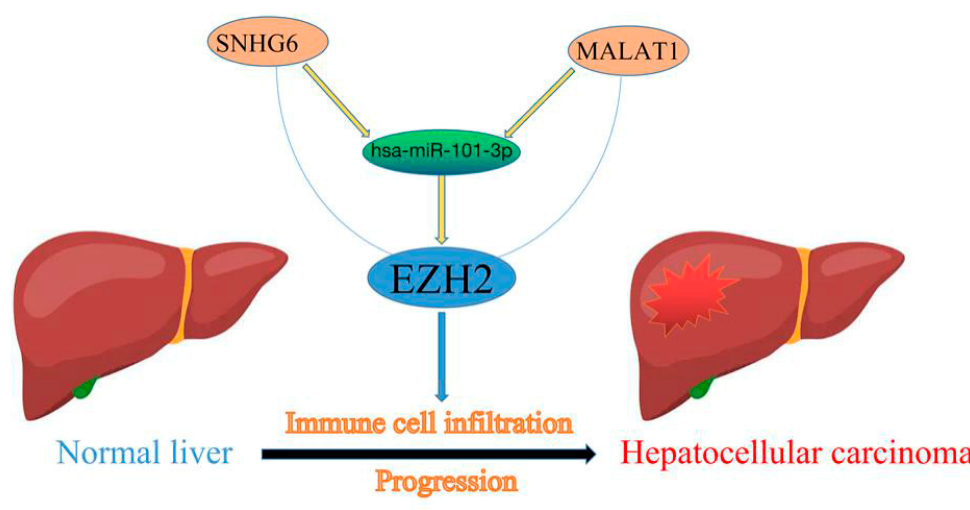
Figure 11. The model of the SNHG6/MALAT1-hsa-miR-101-3p-EZH2 axis in the carcinogenesis of HCC.